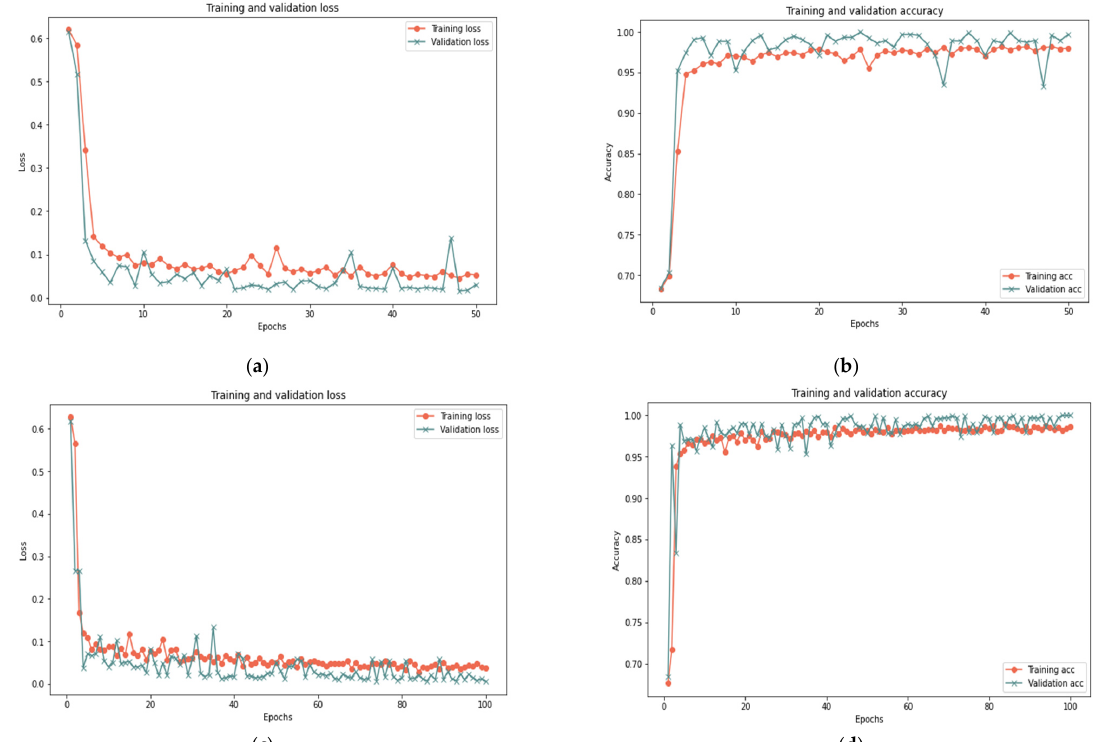
Figure 9. Results of the 100% sample size: ( a ) loss at 50 iterations; ( b ) accuracy at 50 iterations; ( c ) loss at 100 iterations; and ( d ) accuracy at 100 iterations.